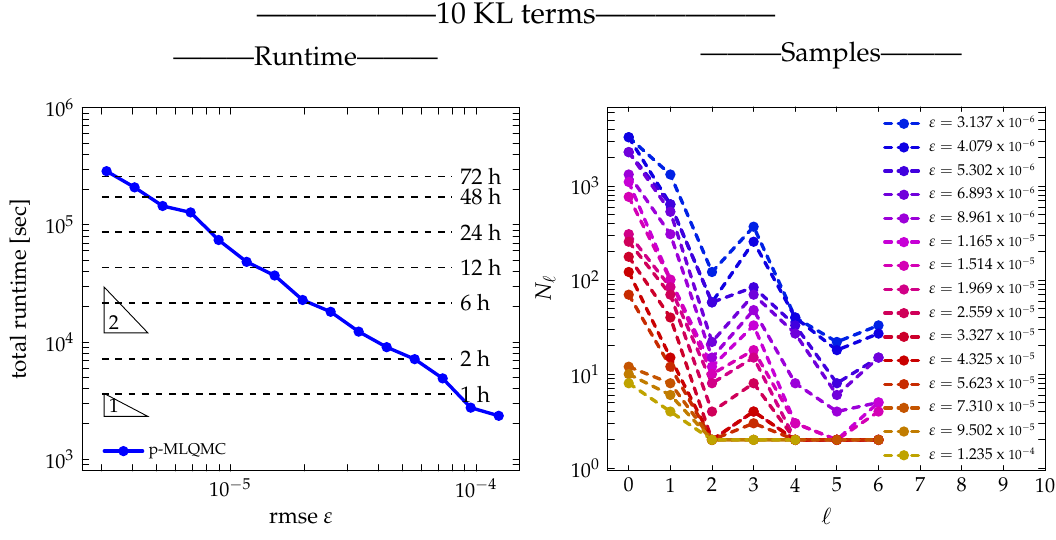
Figure 29. Runtime and sample sizes for a moderate stochastic dimension for model problem 2.